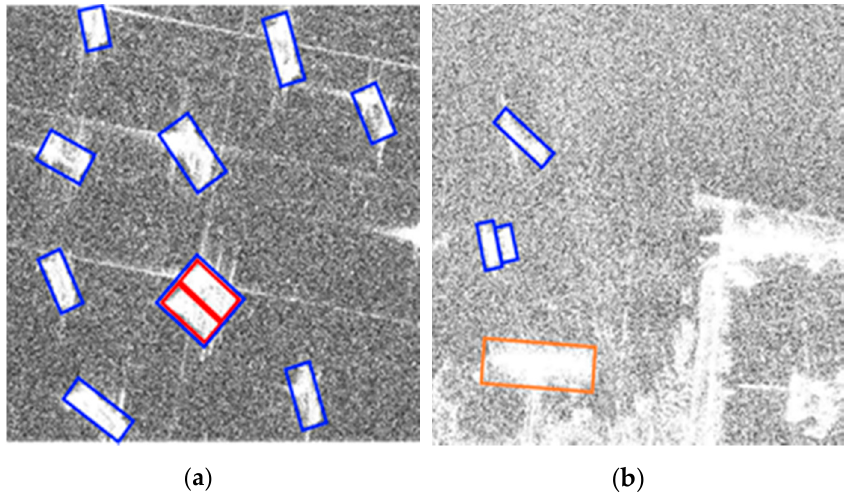
Figure 17. ( a , b ) Undesired result on the AIR-SARShip. Blue bounding box indicates the detected ships, red bounding box indicates the missed ships, and orange bounding box indicates false alarms.